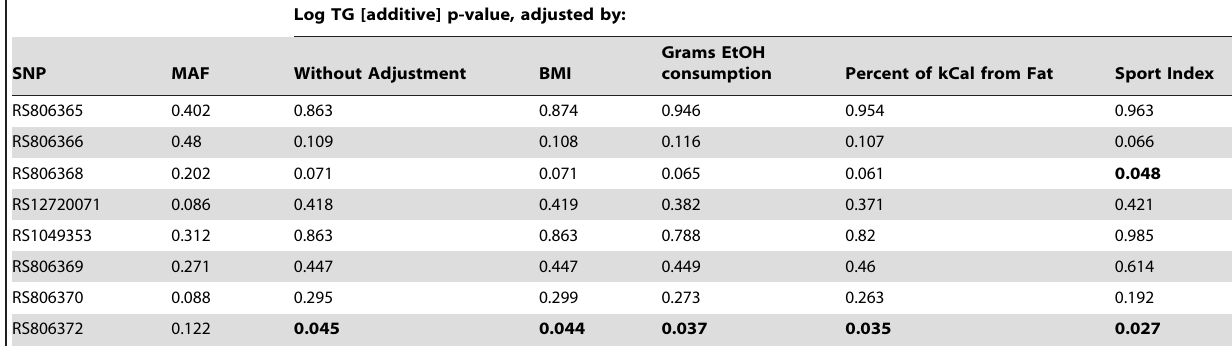
Log TG [additive] p-value, adjusted by: